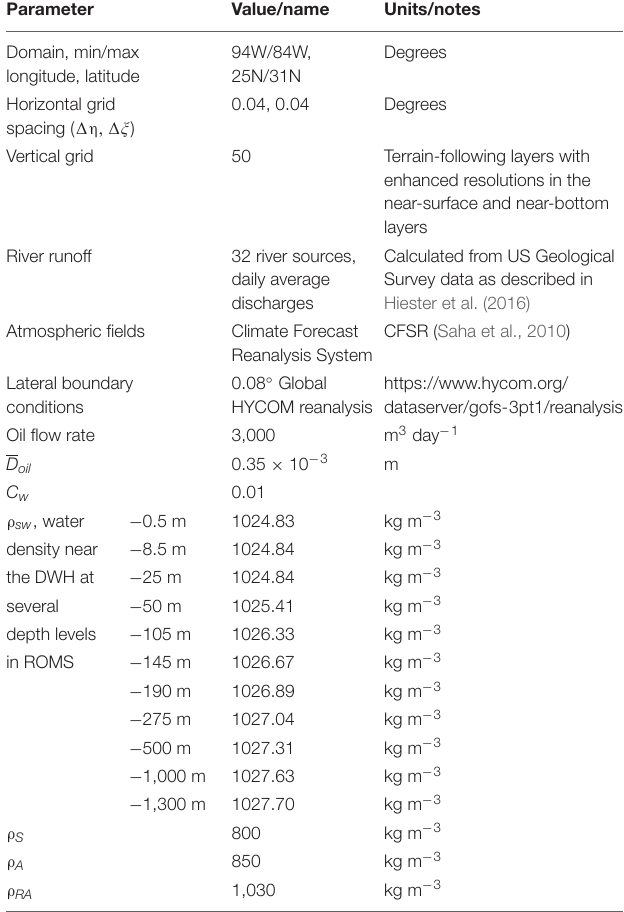
TABLE 1 | Model parameters for test